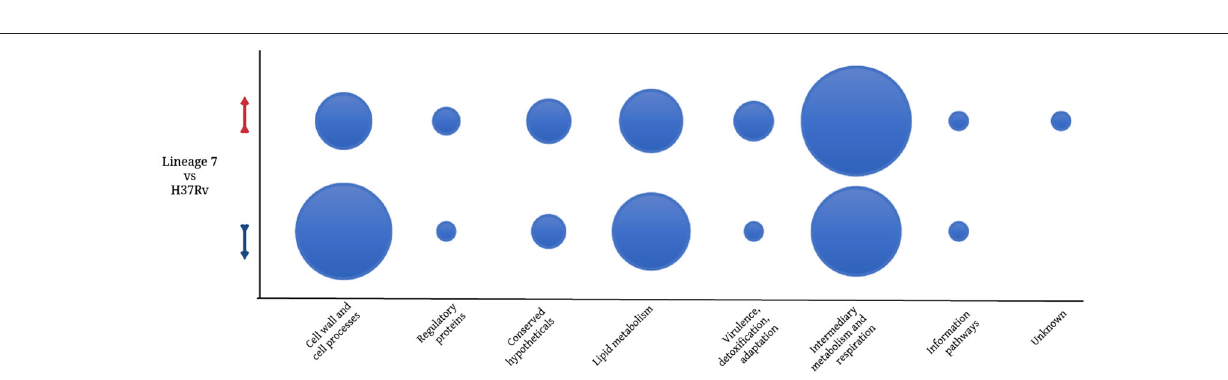
FIGURE 5 | Bubble plot comparing the number of M. tuberculosis differentially abundant proteins in each functional category. Red arrow denotes upregulation and the blue arrow indicates downregulation. Functional categorization was performed according to TubercuList v 2.6